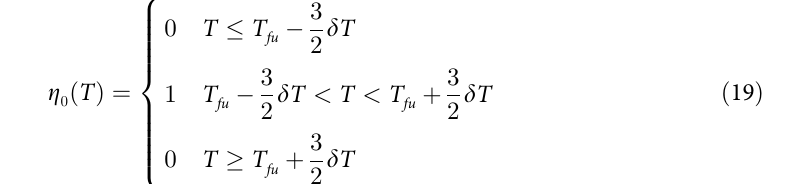
Table 2. The details of the utilized grids when r